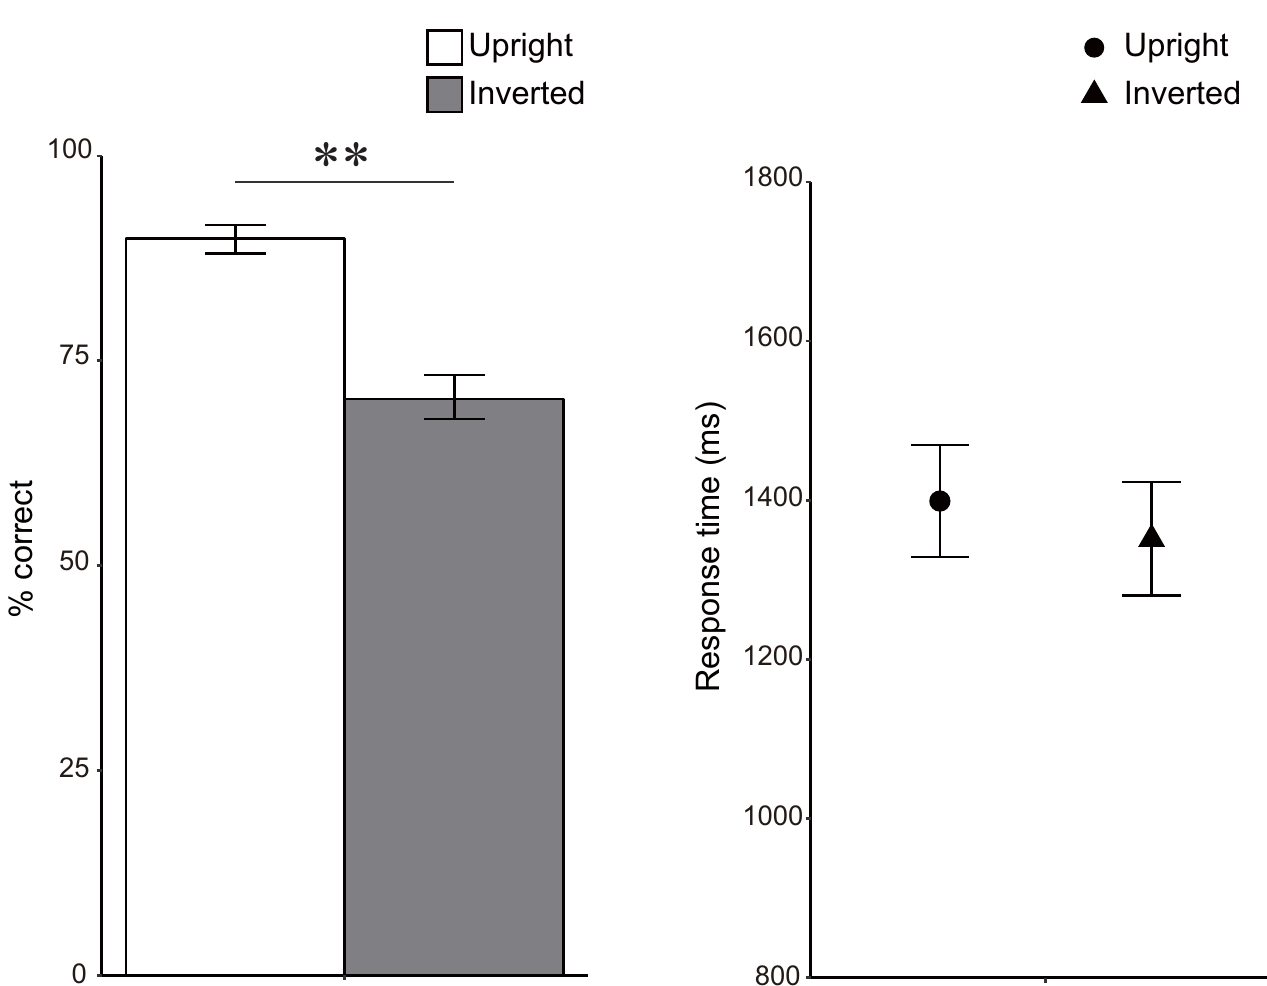
Fig 2. Mean percentages of correct responses and mean response times for correct trials in pretest sessions for monkeys. Error bars indicate bootstrapped 95% confidence intervals. (cid:3)(cid:3) p < .01.